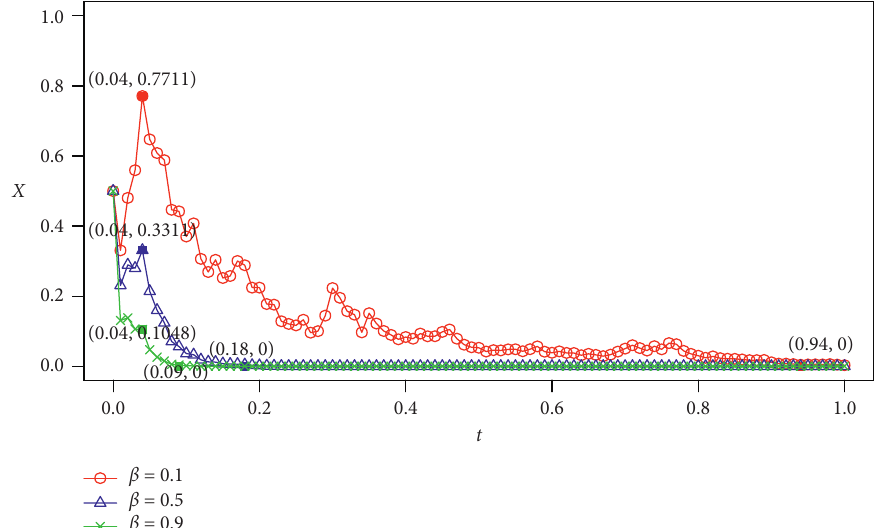
Figure 5: The impact of the degree of punishment β on local government’s strategy selection.